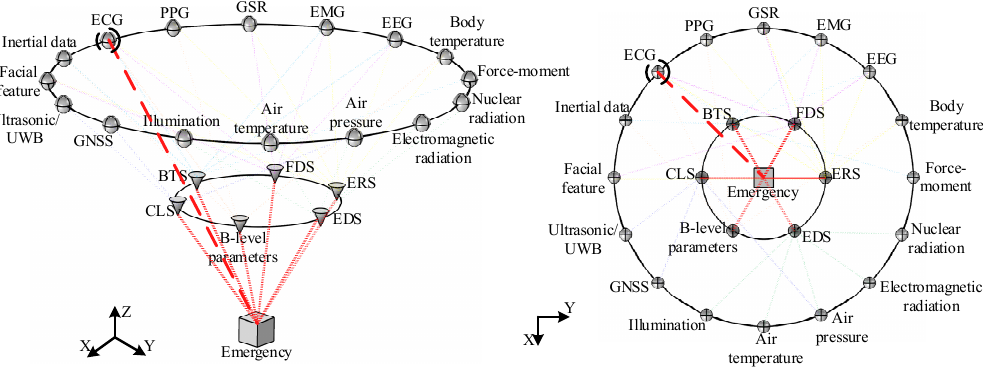
Figure 4. The relationships among all of the framework units are determined based on a summary of the latest research results on wearable technology.